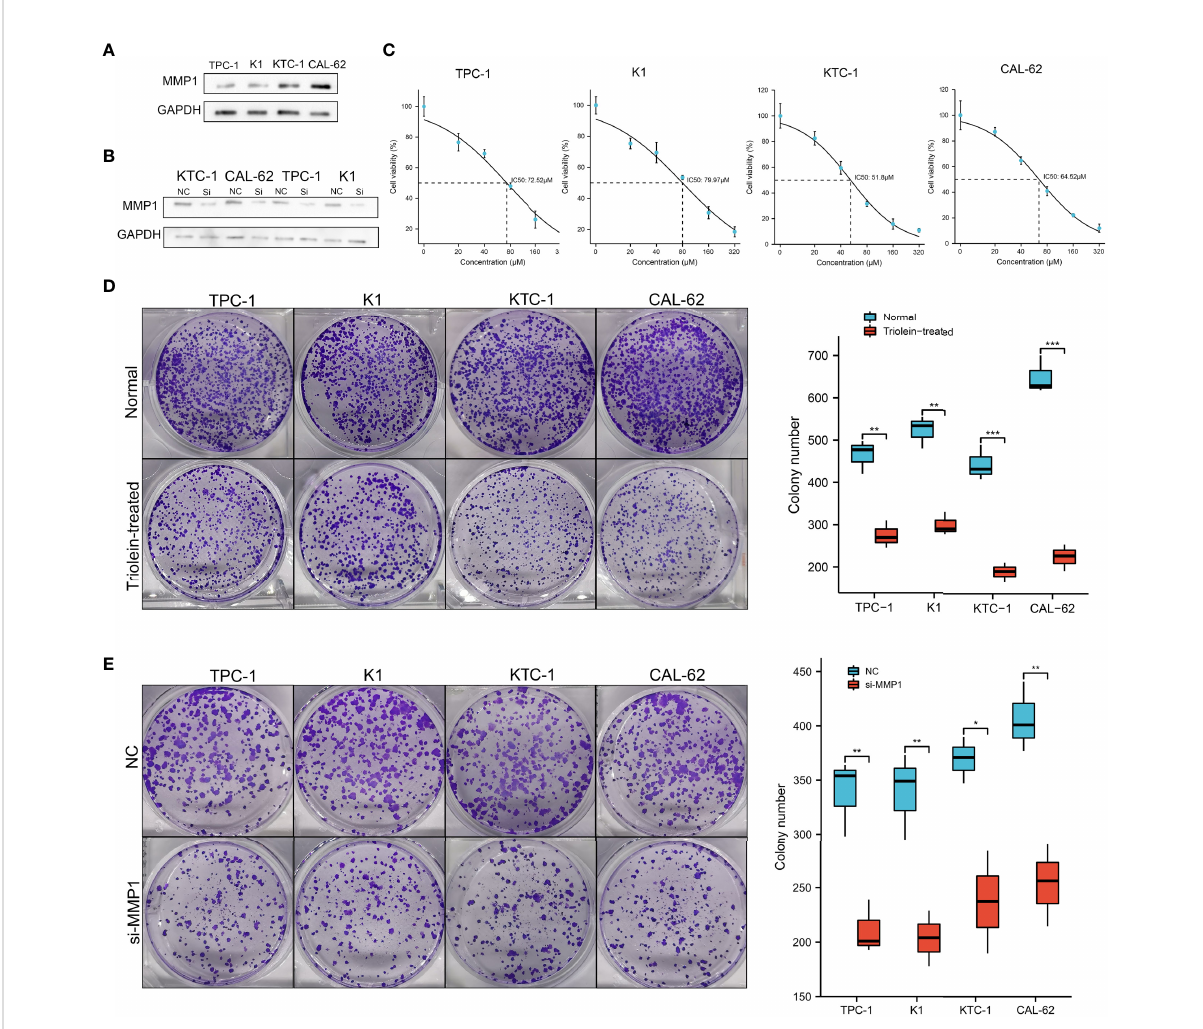
FIGURE 7 Exploration of MMP1 via in vitro experiments. (A) MMP1 was up-regulated in PDTC cell line KTC-1 and ATC cell line CAL-62. (B) MMP1 was signi fi cantly down-regulated in cells after transfection with MMP1 siRNA detected by western blot. (C) IC 50 of triolein in different cell lines. Triolein (D) and MMP1 knockdown (E) inhibited colony formation in different cell lines. PDTC, poorly differentiated thyroid cancer; ATC, anaplastic thyroid cancer; PTC, papillary thyroid cancer; IC 50 , half-maximal inhibitory concentration. *P <0.05, **P <0.01, and ***p